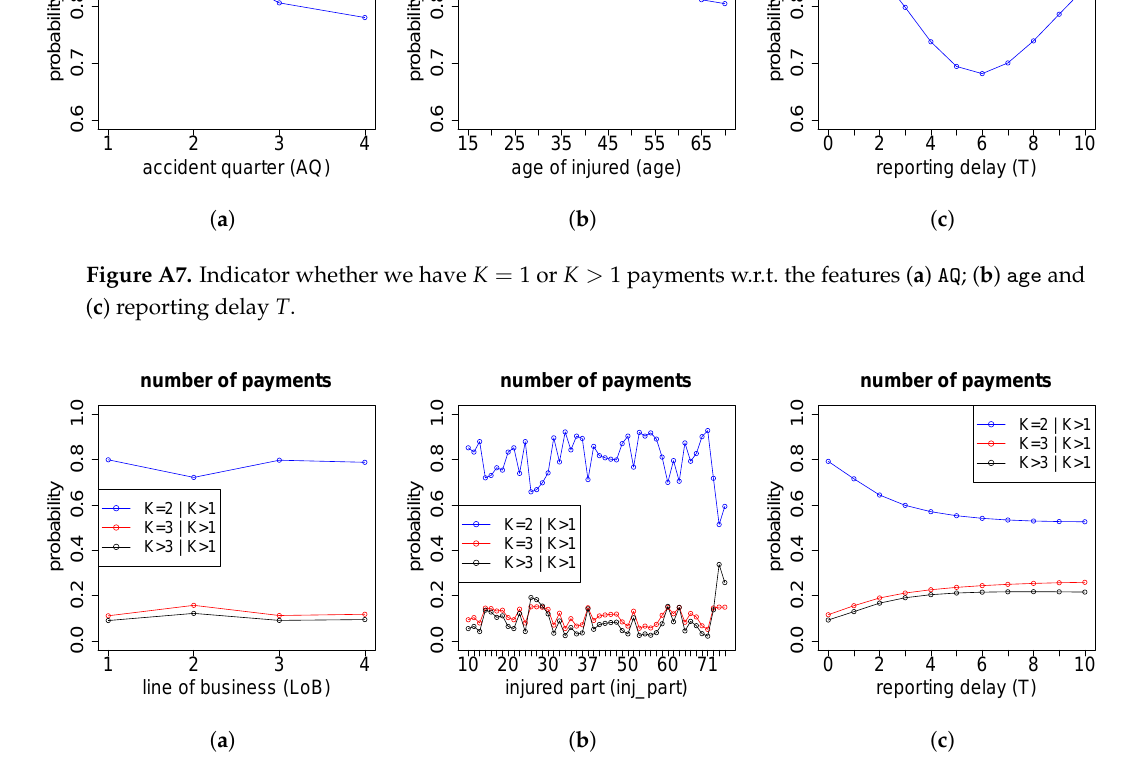
Figure A8. Conditional distribution of the number of payments K , given K > 1, w.r.t. the features ( a ) LoB ; ( b ) inj_part and ( c ) reporting delay T .